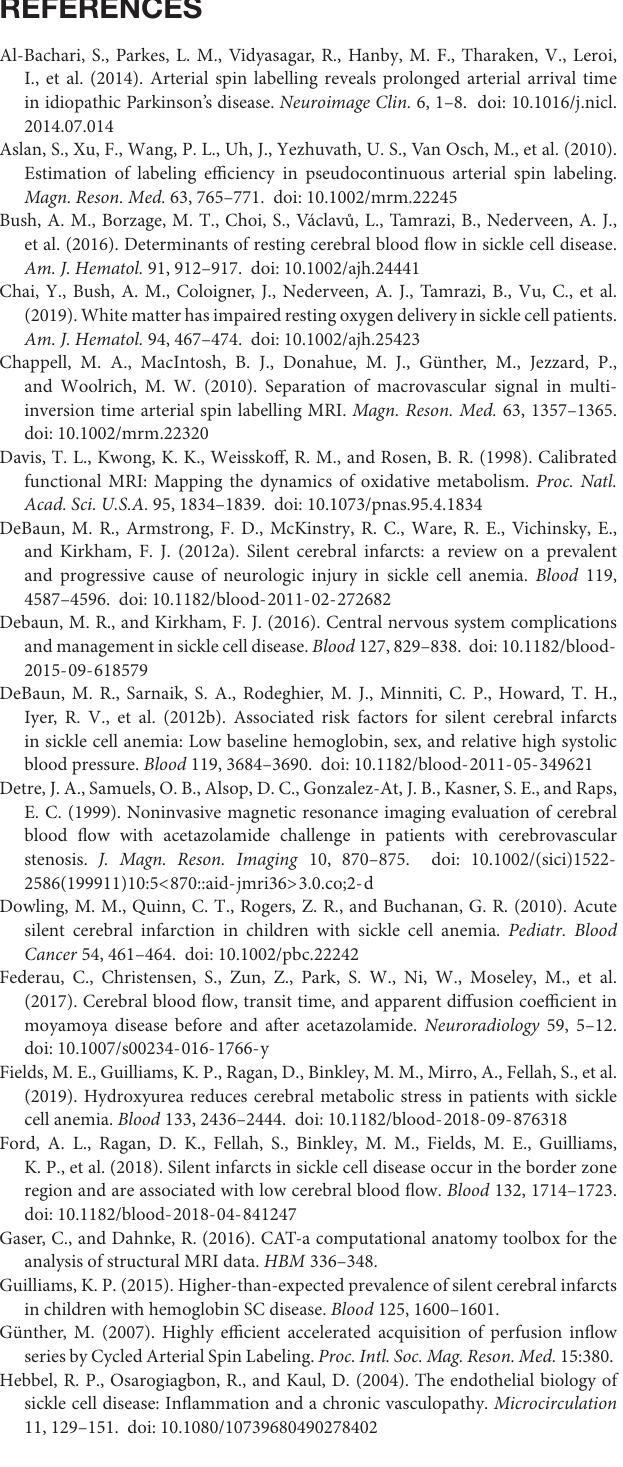
Kruskal-Wallis (H). P -values are shown without multiple comparison correction. Significance level was corrected to 0.017 using Sidak multiple comparison correction. P -values that remain statistically significant after multiple comparison correction are underlined and shown in bold.